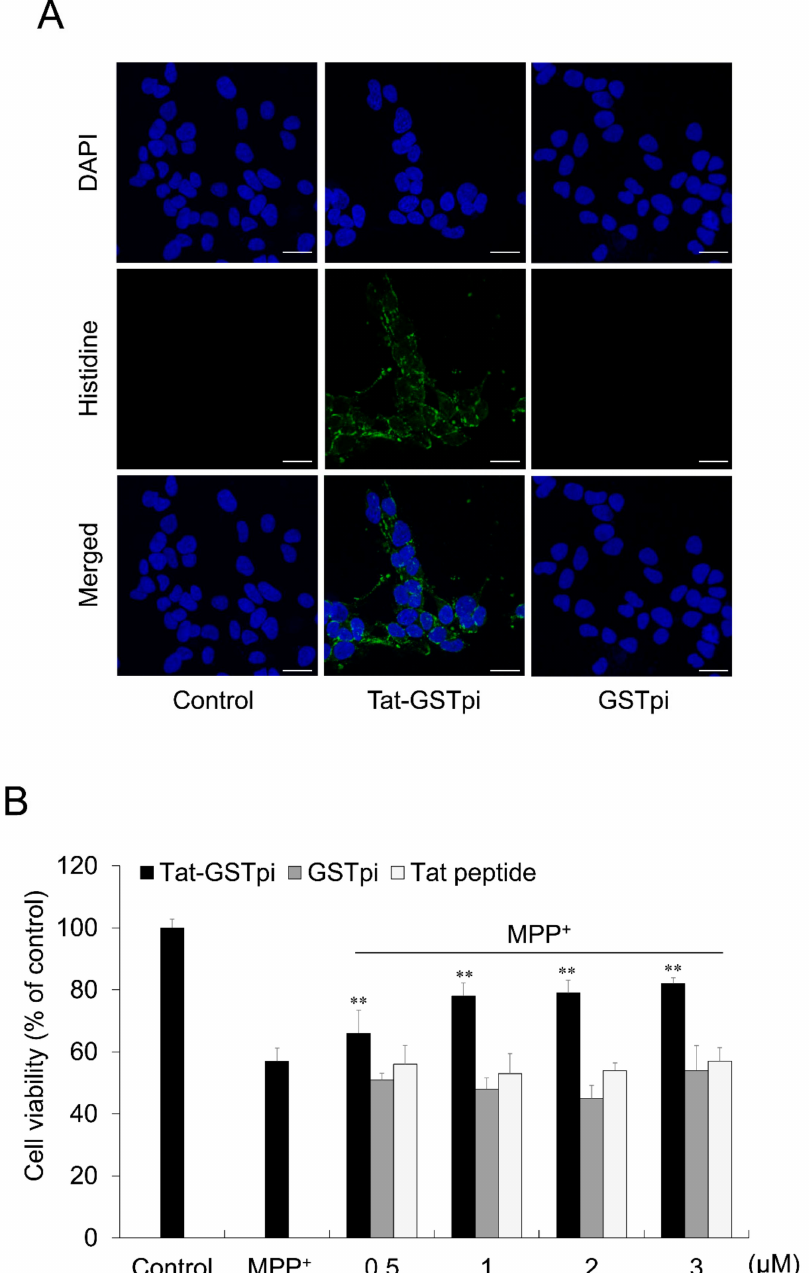
Figure 3. Effect of delivered Tat-GSTpi protein on MPP + -induced SH-SY5Y cell death. ( A ) The localization of delivered Tat-GSTpi protein was detected by confocal fluorescence microscopy. Scale bar = 20 µ m; ( B ) Pretreatment of SH-SY5Y cells with Tat-GSTpi protein (3 µ M), GSTpi protein, and Tat peptide for 1 h and treatment with 5 mM MPP + for 14 h. Then, cell viabilities were estimated using MTT assay. Data are represented as mean ± SEM ( n = 3). Scale bar = 50 µ m. ** p < 0.01, compared with MPP + -treated